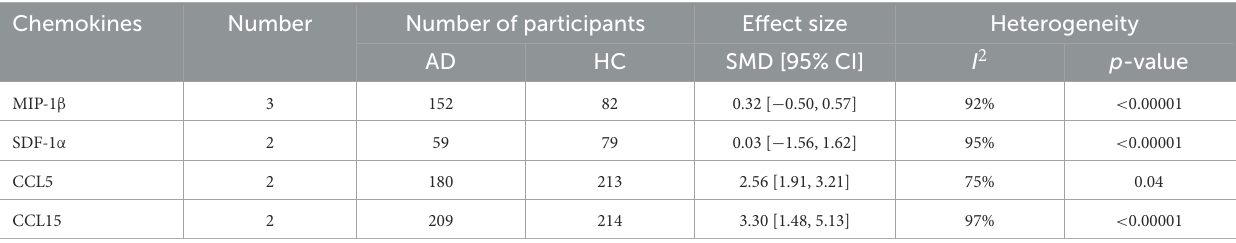
TABLE 2 The amount of chemokines in the blood samples between AD patients and healthy